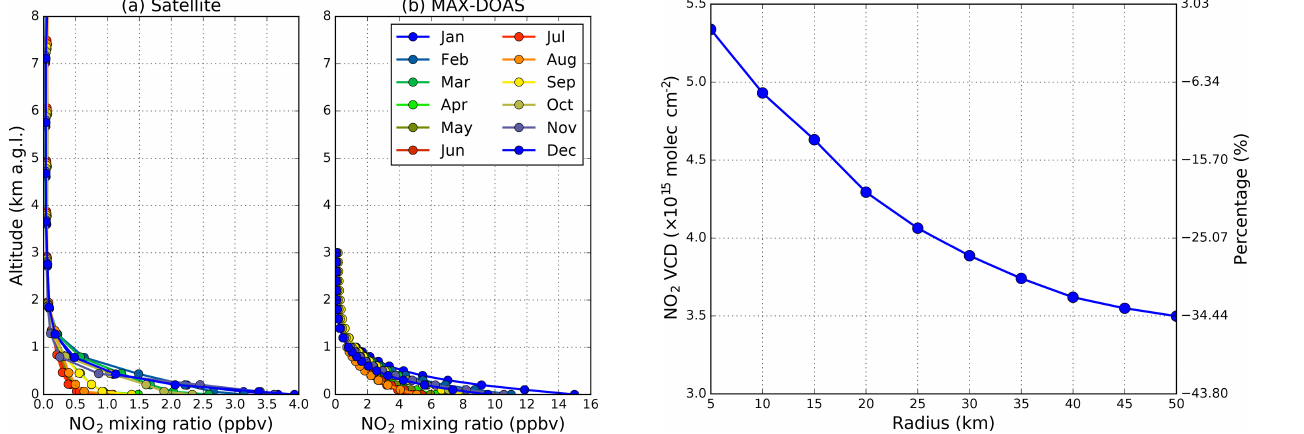
Figure 10. (a) Monthly average of NO 2 a priori profiles used in the satellite retrieval. (b) MAX-DOAS measurements of NO 2 profiles.